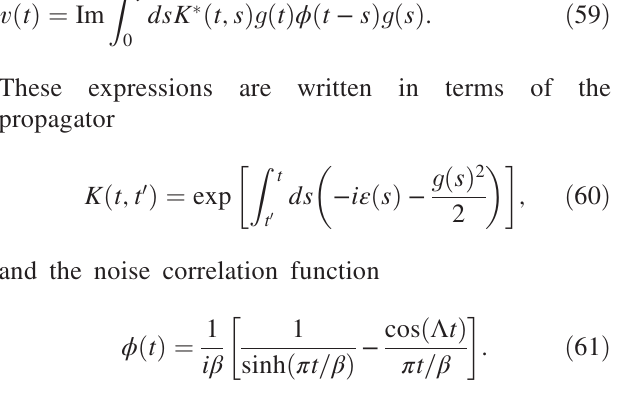
, the on 0 . 01 , and βω 1 . 2 . S ¼ S ¼ , on ¼ ω S to ω f ¼ 2 ω S . S S